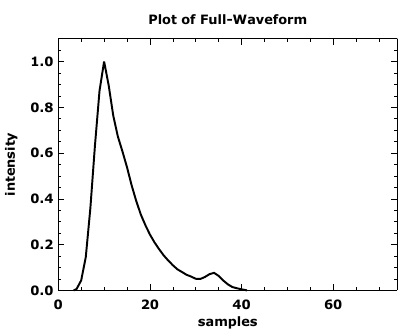
Figure 8. Example for ortho